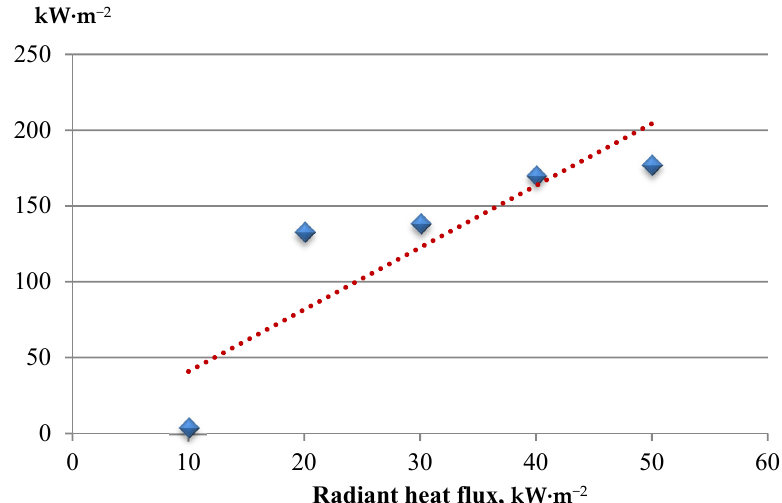
Figure 5. peakHRR as a function of radiant heat flux for a PVC coaxial power cable.